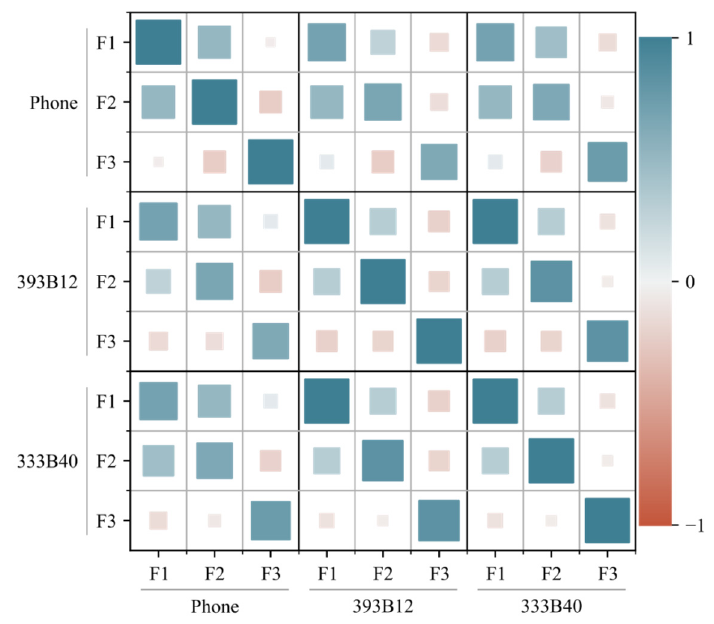
Figure 7. Correlation matrix of the computed natural frequencies.